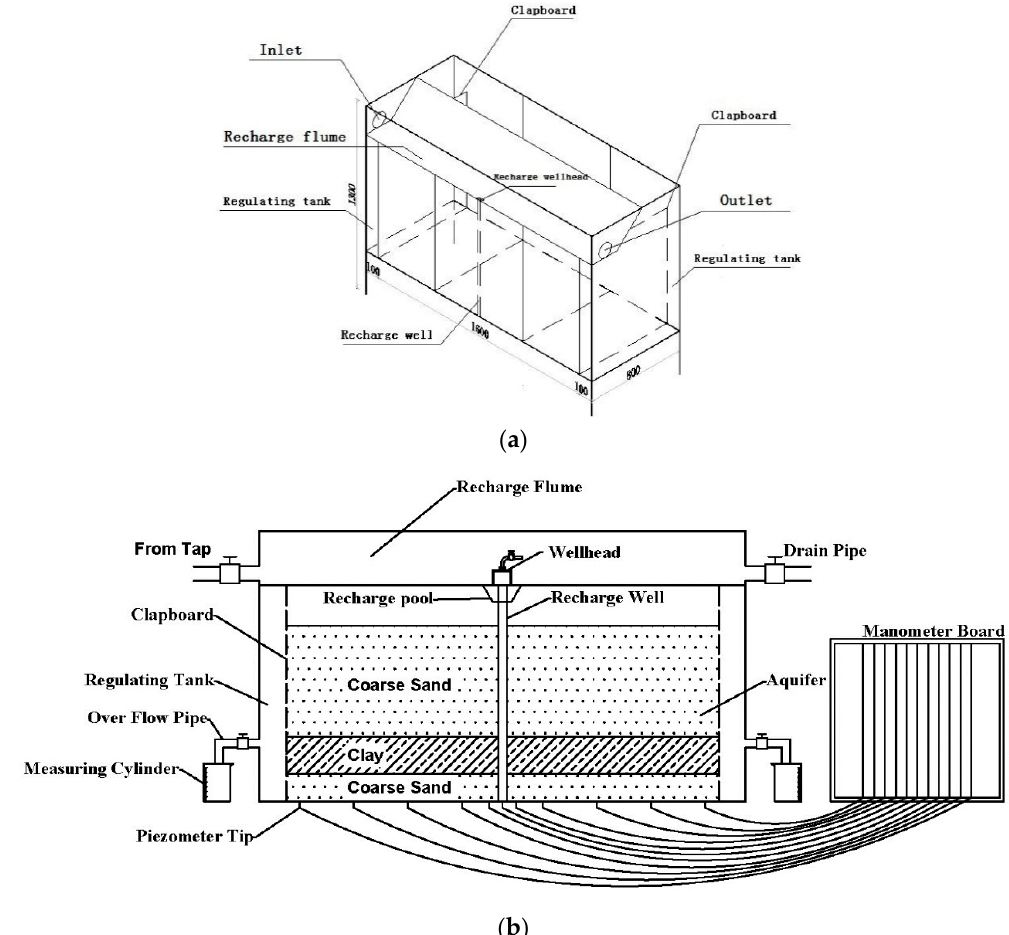
Figure 4. The laboratory recharge test equipment.